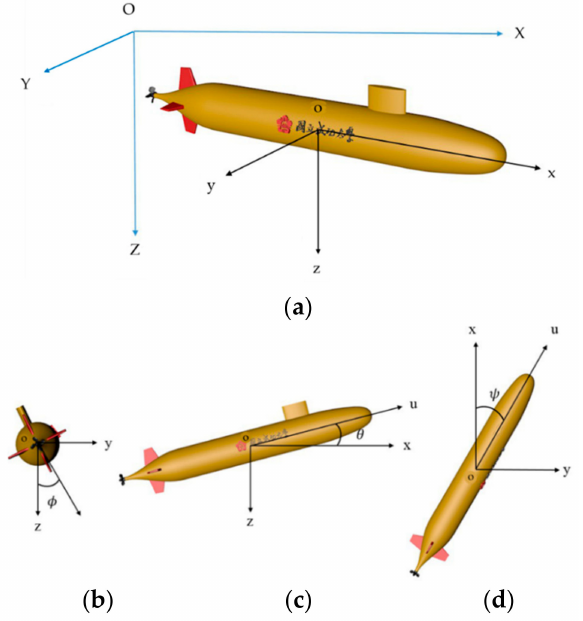
Figure 3. ( a ) The earth-fixed coordinate system; ( b ) rear, ( c ) side, and ( d ) top views of the body-fixed coordinate